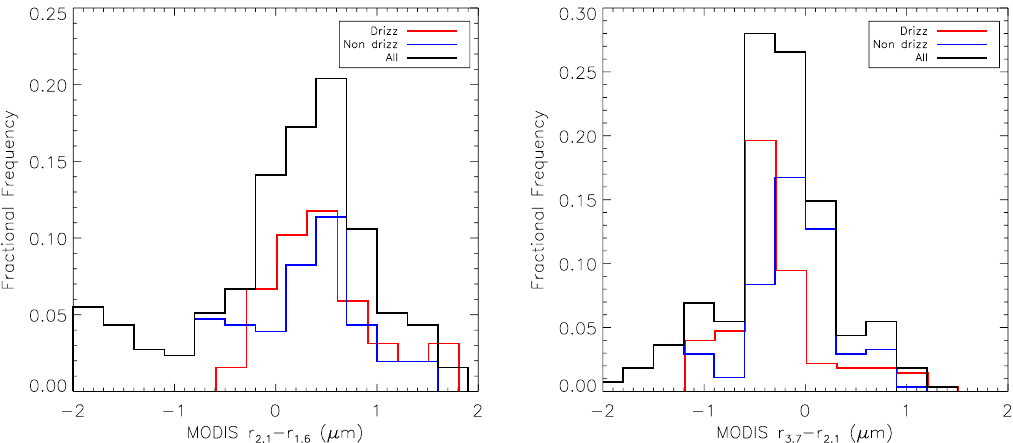
Fig. 9. Differences between all MODIS r e retrievals used in the comparison analysis. Red represents those pixels which are diagnosed as drizzling by being matched to an in situ profile with a 2DS LWP > 2gm − 2 . Blue represents non-drizzling